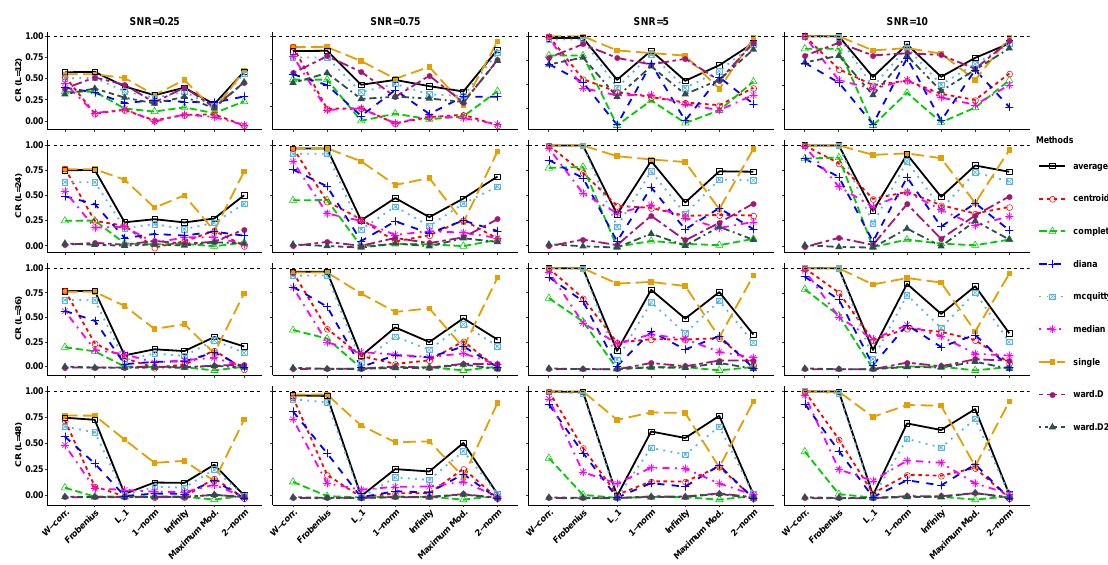
Figure 4. CR index for the sine series (case c).